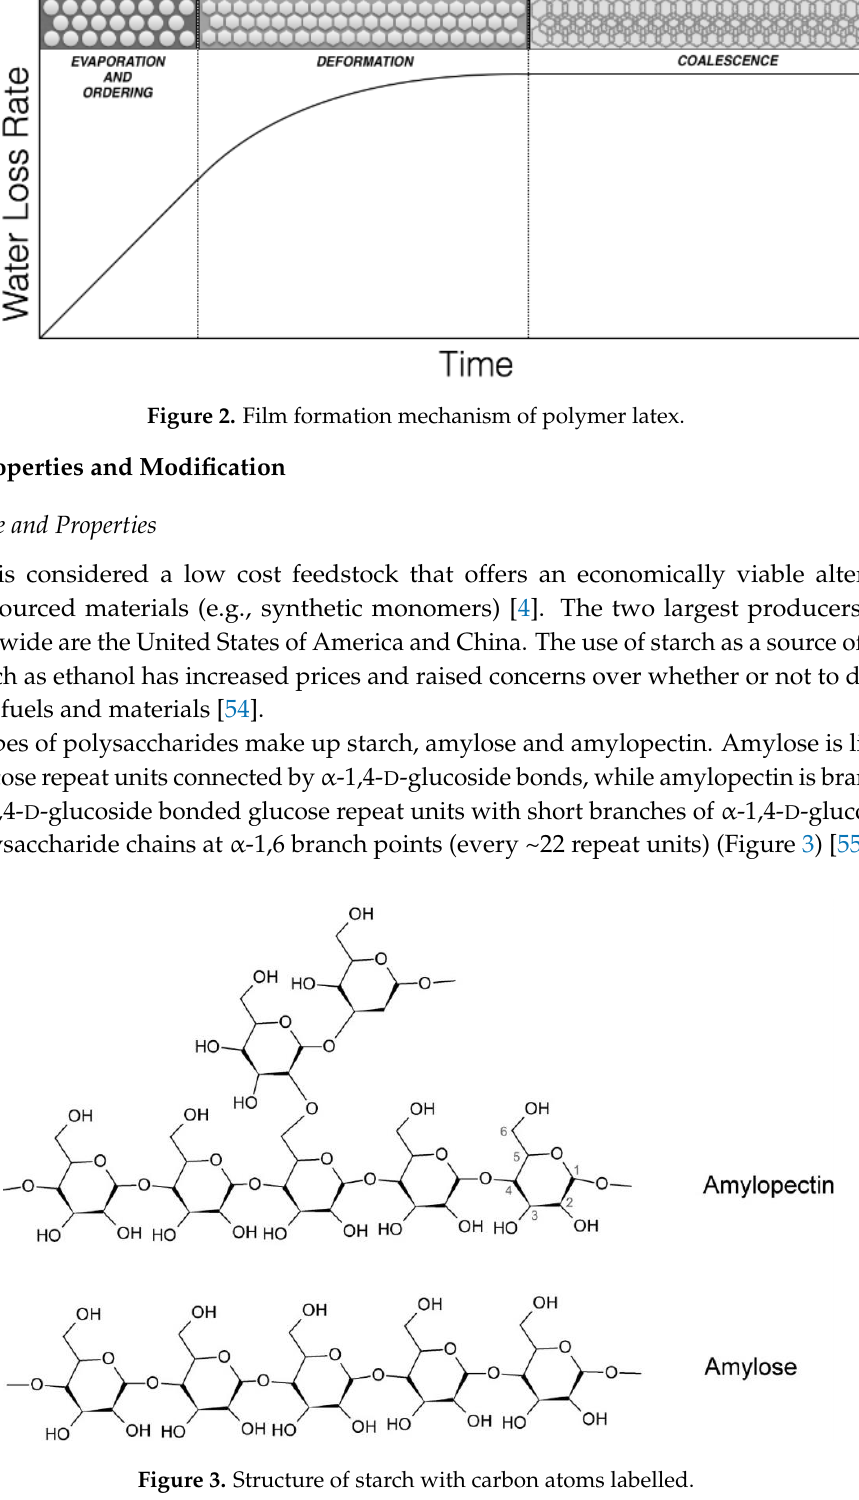
Figure 3. Structure of starch with carbon atoms labelled.